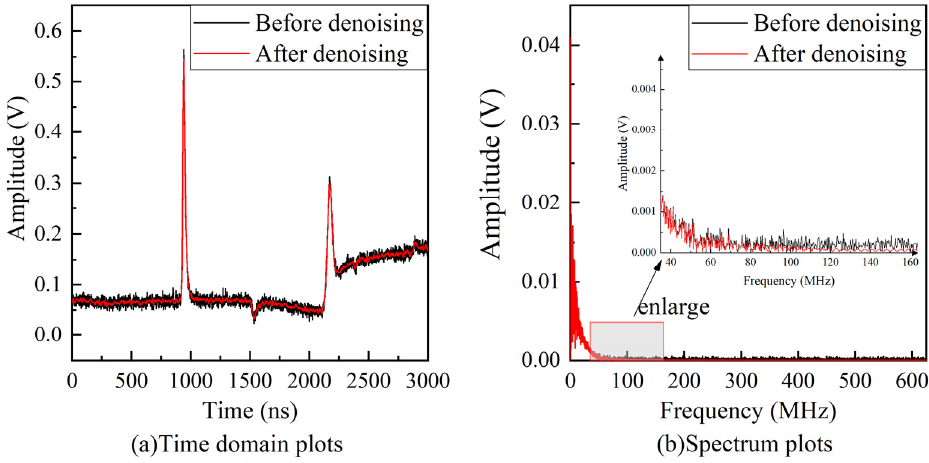
Figure 12. Comparison of the experimental signal before and after